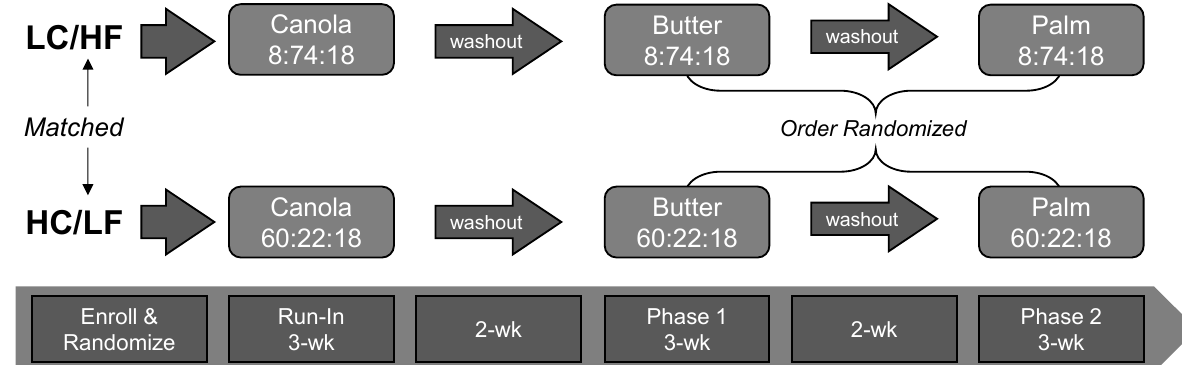
Figure 1. Experimental Approach. Subjects self-selected into the low-carbohydrate/high-fat (LC/HF) or high- carbohydrate/low-fat (HC/LF) diet group. Both groups were fed a 3-wk run-in diet high in canola oil. Baseline testing was performed before and following the canola oil diet phase. This was followed by two randomized and balanced experimental feeding phases that emphasized either butter or palm stearin, separated by a 2-week washout period. Numbers in the boxes with dietary fat source represent the percent energy from carbohydrate, fat and protein, respectively.